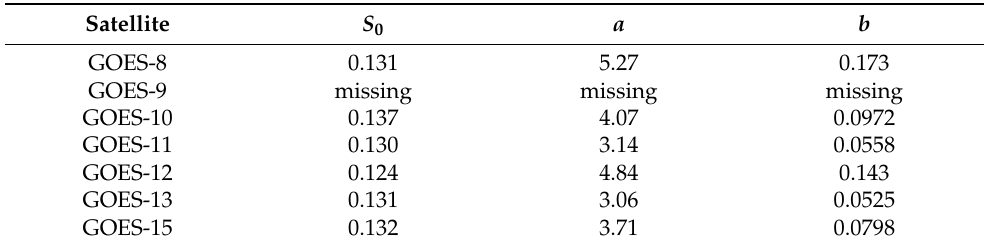
Table A1. NESDIS operational GOES-IP calibration expressed in the PATMOS-x format. GOES-9 was not calibrated by NESDIS operations.